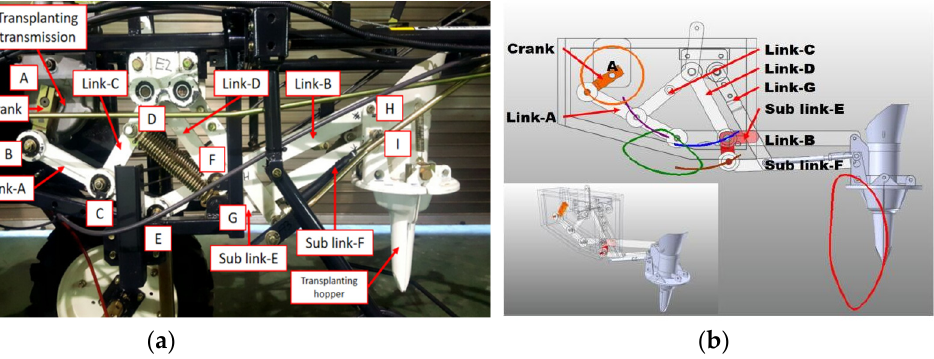
Figure 3. ( a ) The shape of transplanting device, ( b ) 4-bar mechanism of transplanting device of the 4-bar link type semi-automatic vegetable transplanter. Table 2. Mechanical properties and modifying factors of Steel alloy 1020.